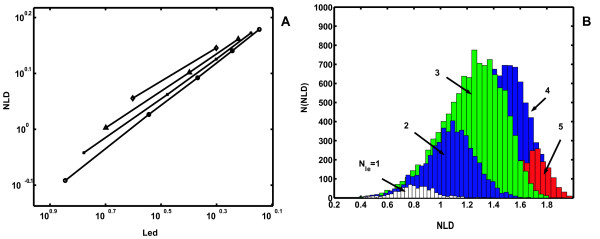
A. Linear dependence of normalized length density (NLD) on the local extrema density (Led) in the log-log scale. Data on each line were derived from 30000 short epochs with different lengths (o - 7; x - 6; Δ - 5; ◇ - 4 samples). Epochs consisted of randomly generated samples in the range (0,1). B. Distributions of number of generated epochs, N(NLD), by their NLD values, derived from the 30000 seven-sample epochs from panel A. Histograms differ in the number of local extrema detected on the epochs (Nle), and positions of their peaks correspond to ordinate values of circles on A.